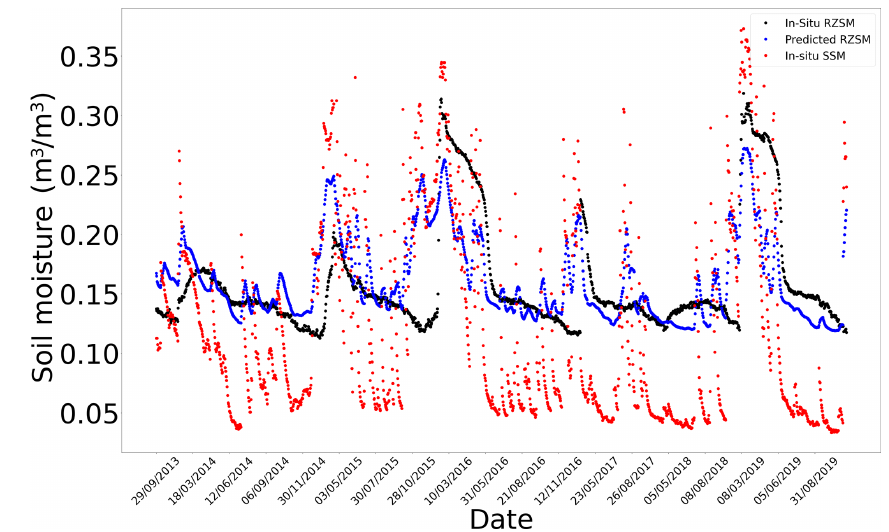
Figure E3. In situ SSM, in situ RZSM, and predicted RZSM series at station HarmsWay (SCAN) with model ANN_SSM.